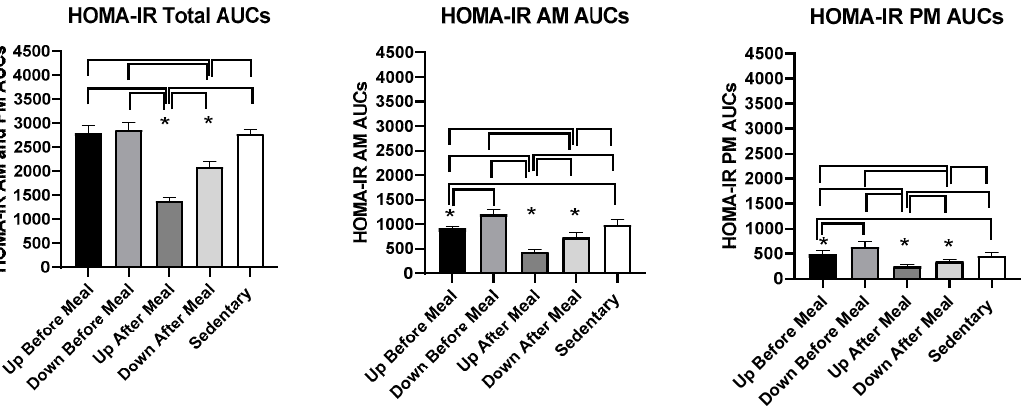
Figure 10. Postprandial homeostatic model (HOMA-IR) AUCs after the morning and afternoon meals combined (left) and after the morning (center) and afternoon (right) meals individually. A consistent reduction in HOMA-IR AUCs was seen only for the UAM exercise-after-meal trial in comparison to SED, two exercise-before-meal trials, and in the afternoon also relative to DAM, the other exercise-after-meal trial. * indicates significant di ff erence relative to groups marked by the overhead